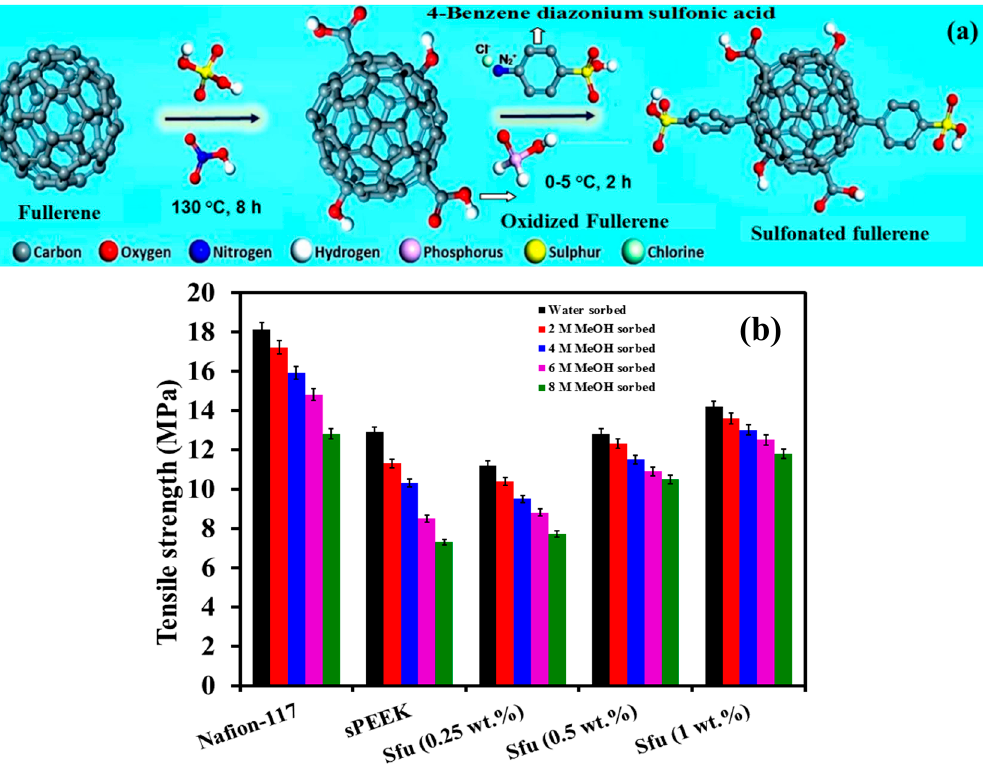
Figure 16. ( a ) Schematic representation of sulfonation procedure for fullerene and ( b ) tensile strength of SPEEK-S-fullerene membranes after equilibrating in different concentration of methanol (0–8 M). Rreproduced from [76], with permission from Elsevier, 2016.